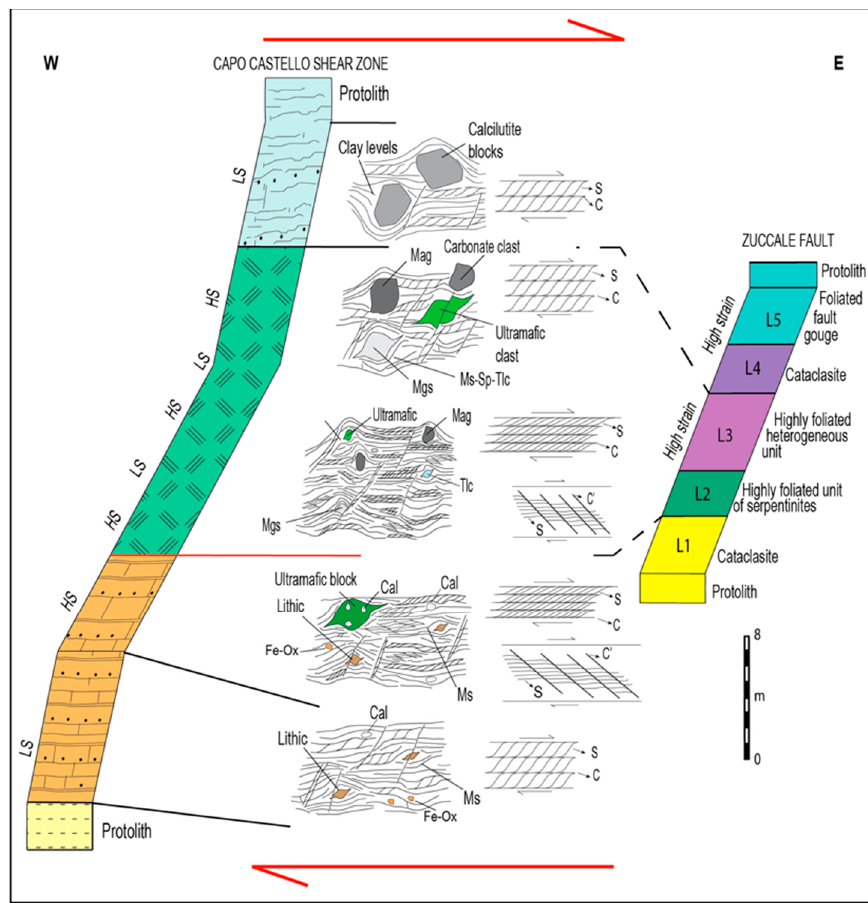
Figure 14. Sketch comparing the Capo Castello shear zone and the Zuccale normal fault stratigraphy. Along the Capo Castello shear zone log, the different strain domains are represented. The Zuccale normal fault log is reconstructed taking into account [56]. L1 : cataclasite, locally with protomylonitic basement clasts, in a carbonate-quartz-chlorite matrix; L2 : highly foliated unit of serpentinite plus tremolite-talc-chlorite schist; L3 : highly heterogeneous unit of chlorite phyllonites with lenses of carbonate mylonite; L4 : carbonate vein-rich unit set in a cataclasite with carbonate and ultramafic lenses; L5 : foliated fault gouge and fault breccia. Deformation structures and deformation mechanisms of L2 – L3 units are similar to the ones of the serpentinite levels in the Capo Castello shear zone. Finally, even if no dating is available in this area, the activity of the Capo Castello shear zone can be encompassed between 19.8 ± 1.4 Ma ([33], age of HP event) and late Miocene–Early Pliocene (age of Zuccale activity, [59]). In this view, the west dipping F-structures (i.e., the latest brittle deformation), accommodated the passive rotation of the